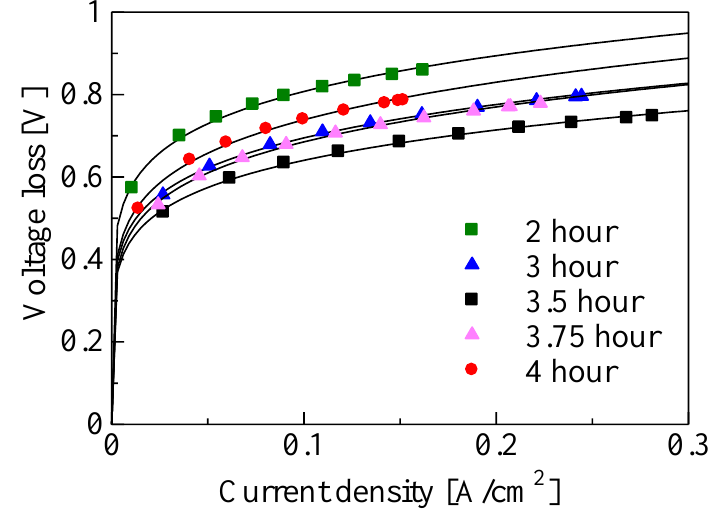
Figure 6. Activated polarization for various growth times.